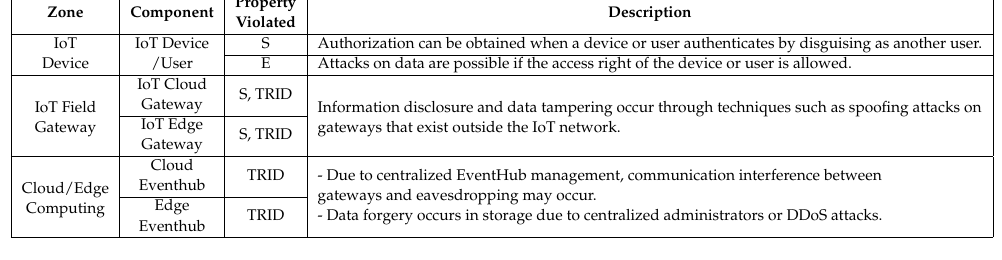
Table 4. STRIDE threat modeling—results.